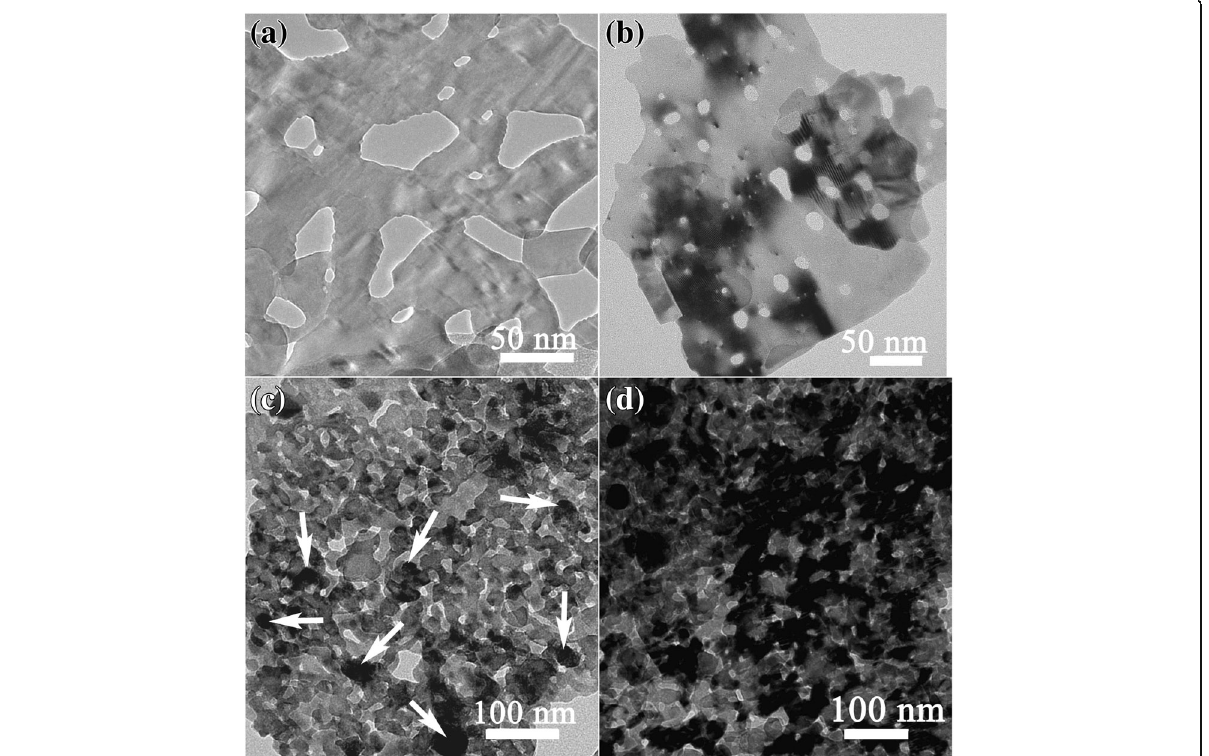
Fig. 2 TEM images of BiVO 4 -modifying ZnO PNSs with different Bi/Zn molar ratios: a ZnO, b ZB_0.01, c ZB_0.05, and d ZB_0.2, showing the evolution of surface morphology as the increasing Bi/Zn molar